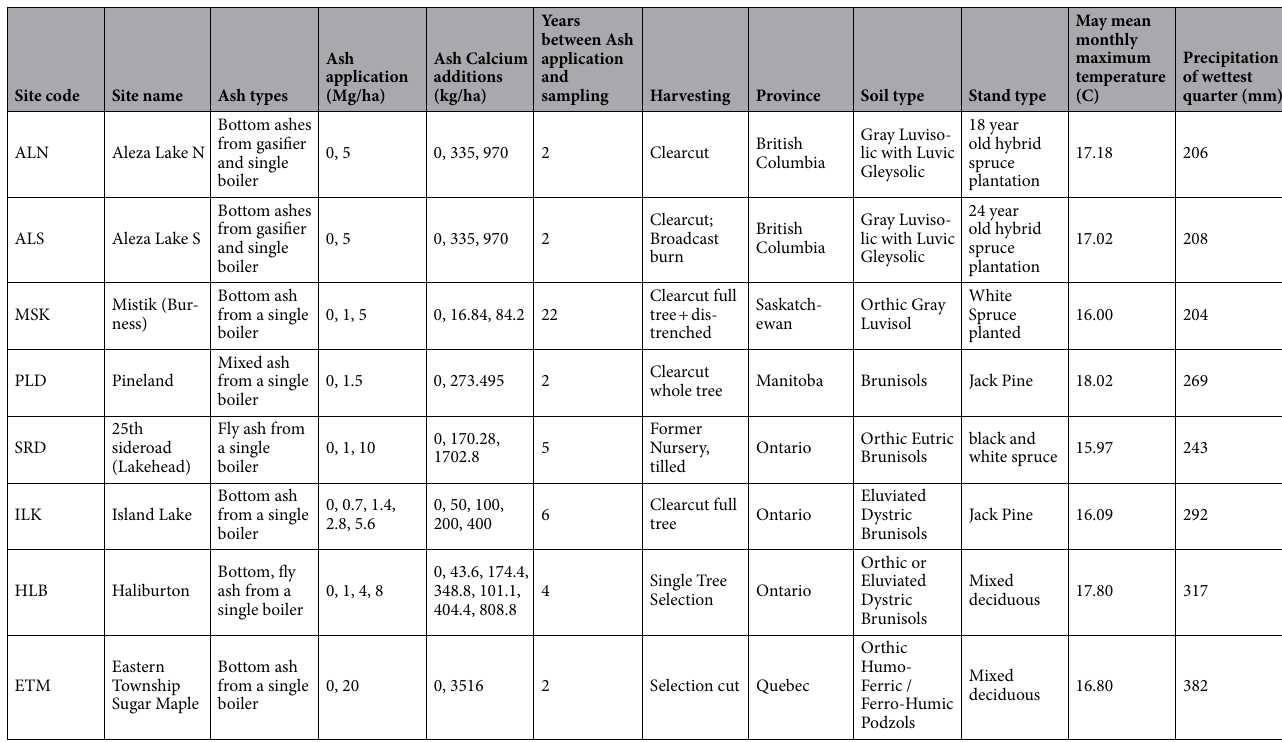
Table 1. Site and climate characteristics associated with the eight AshNet sites used in this study.